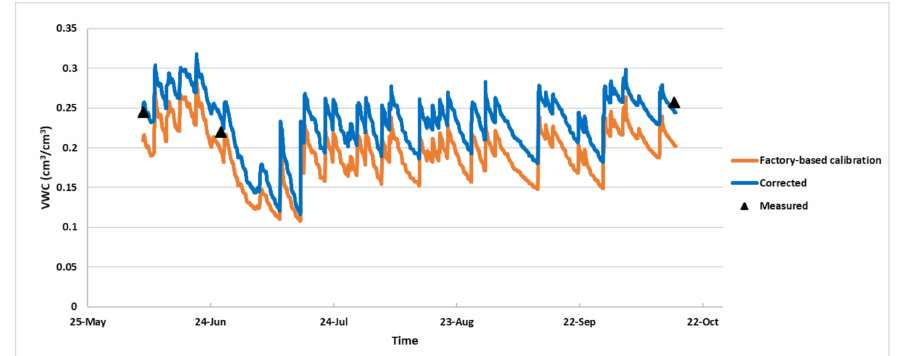
Figure 7. Comparison of factory-based calibration to corrected values for CS616 in sandy clay